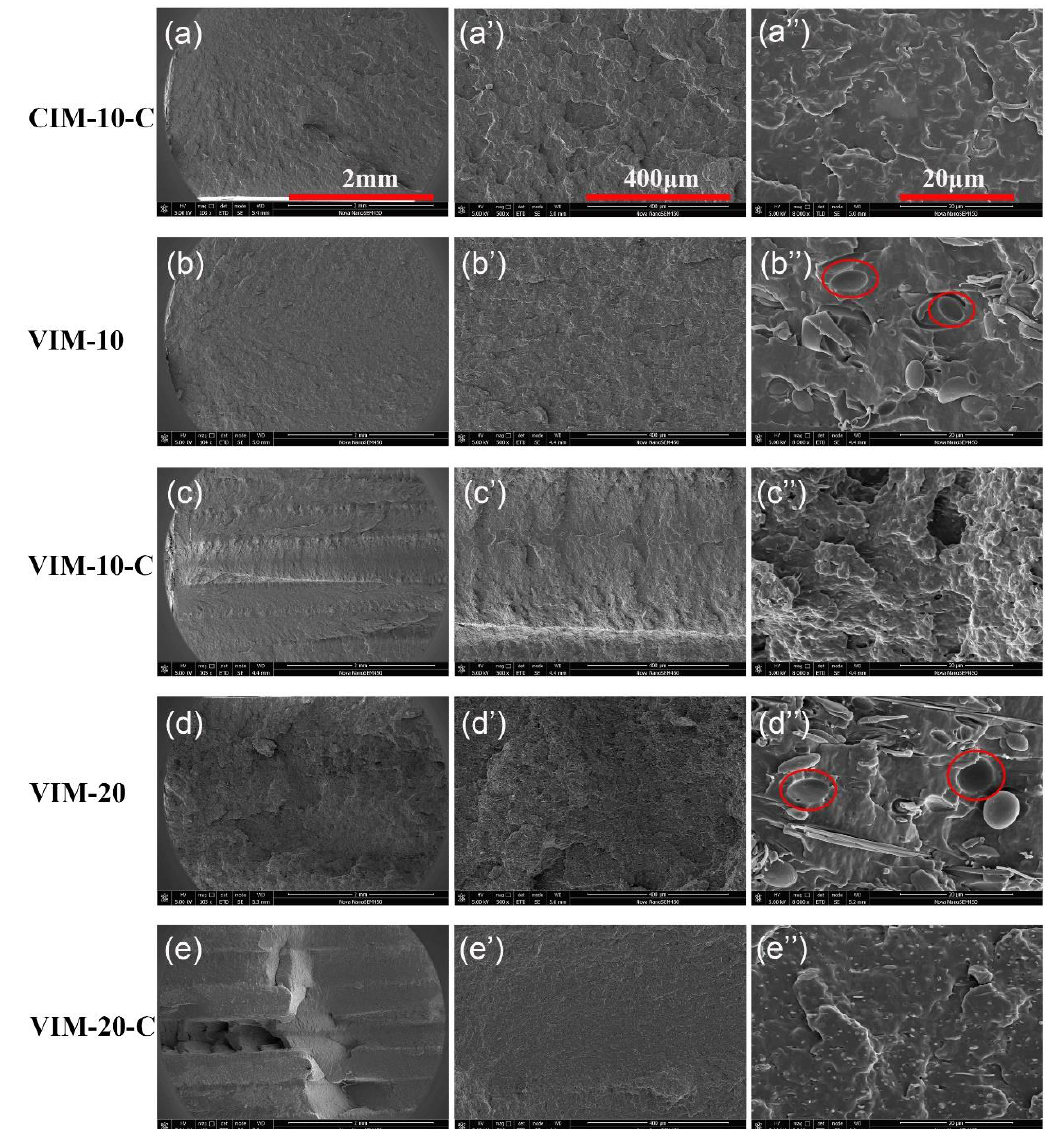
Figure 10. Impact fracture surfaces. ( a’ – e’ ) and ( a’’ – e’’ ) are magnified pictures. Impact direction is horizontal. is